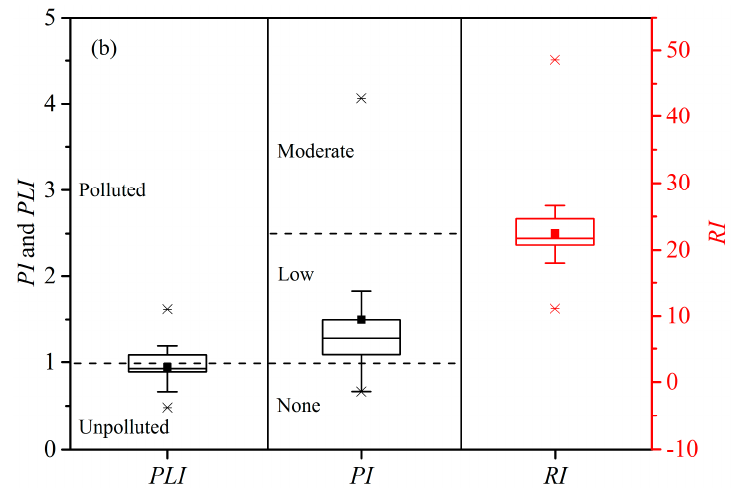
Figure 3. CF , PLI , PI, and RI values of heavy metals in the sediment from the Lishui River. ( a ) CF values; ( b ) PLI , PI and RI values.